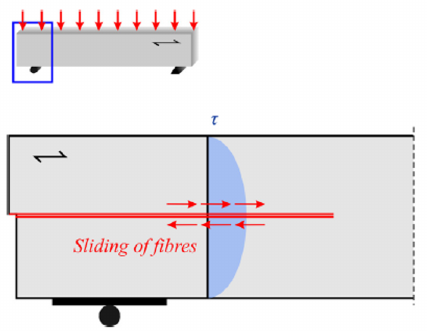
Figure 5. Three-point bending test (3PBT) config- uration common for all the beams: length of 40 cm, cross-section height of 10 cm and single edge notch length l n of 1